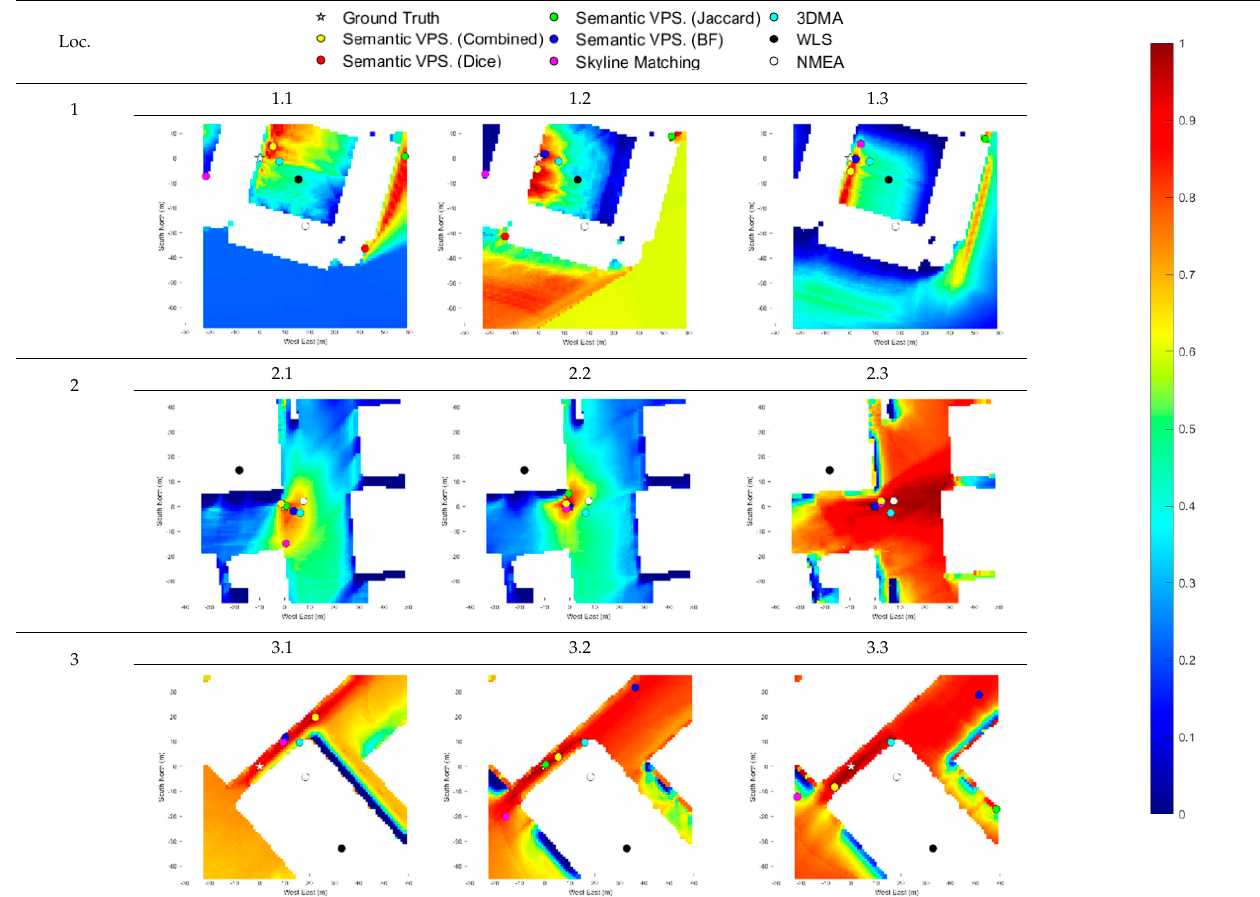
Table 4. Heatmap of the likelihood of candidate images compared to the smartphone image based on the proposed semantic VPS method. Loc.